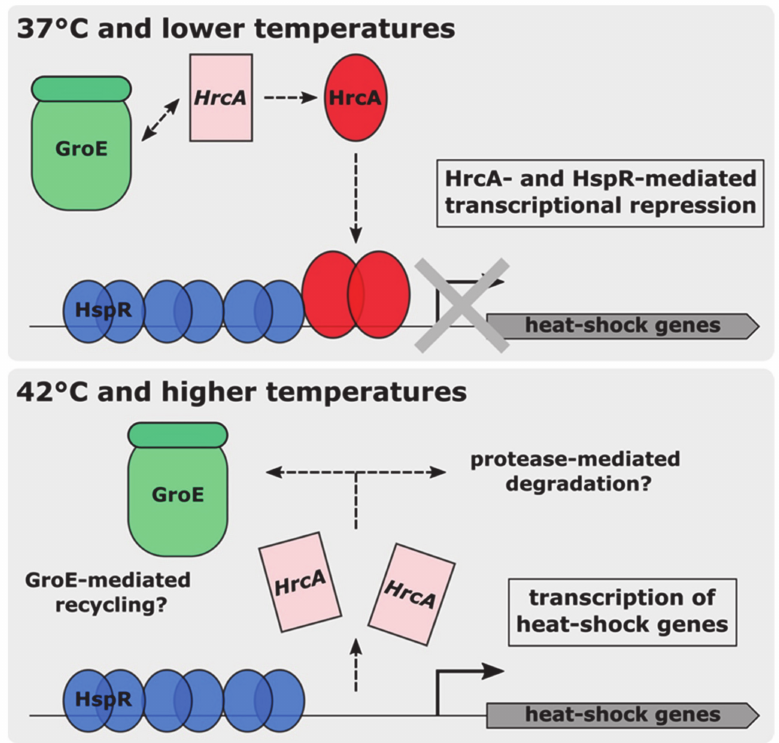
Figure 8. Model for heat-sensing in C. jejuni , representing a HrcA-HspR co-repressed promoter. Blue and red ovals represent HspR and HrcA, respectively, in their DNA-binding competent conformation, while light pink rectangles depict HrcA inactive conformation. Following an interaction with the GroE chaperonin, HrcA acquires its active conformation and binds to its operators, contributing to the transcriptional repression of heat-shock genes (upper panel). Upon a temperature increase, HrcA loses its binding capabilities and detaches from its binding sites (lower panel). It can be hypothesized that the heat-inactivated HrcA is degraded by cellular proteases. Moreover, it cannot be excluded that a fraction of inactive HrcA is actively refolded by the GroE chaperonin.